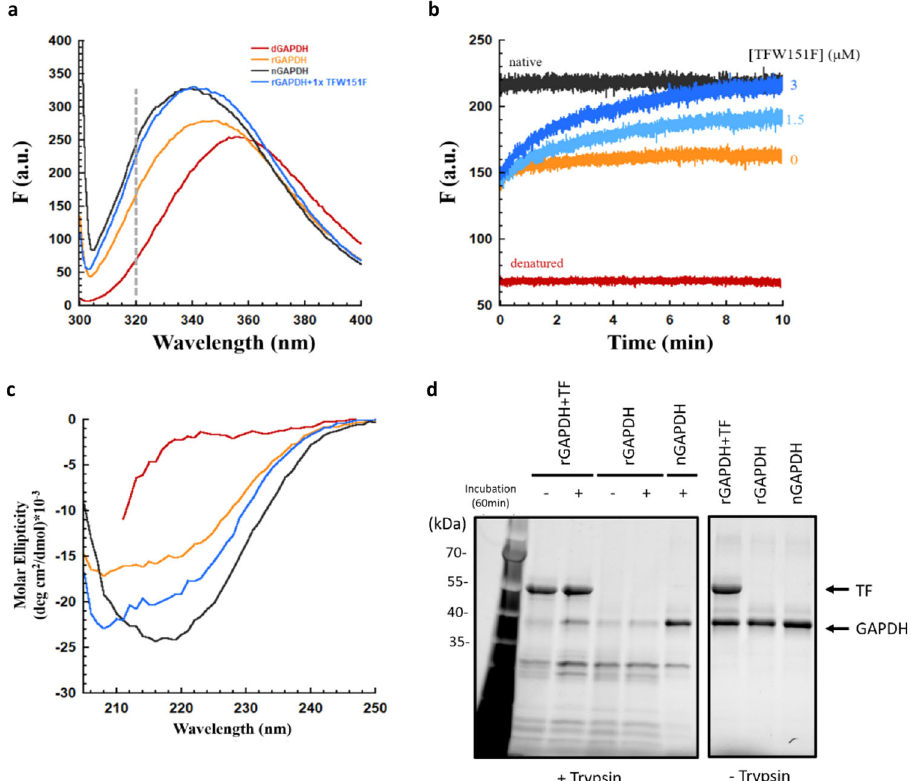
Fig. 3 GAPDH slowly refolds to a near-native state in the presence of trigger factor. a Tryptophan fl uorescence spectrum of 3 μ M refolding GAPDH (rGAPDH) with an equimolar amount of trigger factor W151F (rGAPDH + 1x TFW151F; blue line) is similar to the spectrum of native GAPDH (nGAPDH; black line), but different from the one of GdnHCl-denatured GAPDH (dGAPDH; red line) and refolding GAPDH (rGAPDH; orange line). All the spectra were measured in buffer A containing 0.26 M GdnHCl at 4 °C, except the spectrum of GdnHCl-denatured GAPDH which was measured in buffer A containing 3 M GdnHCl. The emission wavelength of 320 nm, which was marked as a grey dash line, was used to monitor the kinetics in Fig. 3b. a.u.: arbitrary units. b Changes in tryptophan fl uorescence of 3 μ M refolding GAPDH in the presence of various concentrations of trigger factor W151F (0, 1.5, 3 μ M) at 4 °C. Tryptophan residues were excited at 296 nm and fl uorescence emission was monitored at 320 nm. Upon dilution into buffer A, GAPDH slowly refolds to a near-native state, which exhibited a similar fl uorescence intensity as native GAPDH, within 10 min. a.u.: arbitrary units. c Circular dichroism spectra of 8.4 μ M GAPDH in a denatured state (red line), native state (black line), refolding state (orange line) and the trigger factor-bound state (blue line). All the samples were incubated on ice for 1.5 h prior to recording the spectrum. Upon dilution into buffer A, a signi fi cant increase in the signal of circular dichroism at 220 nm was observed. Addition of the trigger factor further increased the signal at 220 nm, suggesting that GAPDH increases the fraction of secondary structure in the presence of the trigger factor. d The conformational change of 5 μ M GAPDH in the presence of trigger factor as probed by limited proteolysis with trypsin. All the samples were either directly digested with 12.5 μ g/ml trypsin for 1 min at room temperature or incubated on ice for 1 h before trypsin digestion. Samples were then analysed by 4 – 15% Mini-PROTEAN TGX stain-free gels. The gel shows that refolding GAPDH in the presence of trigger factor (rGAPDH + TF) is more protease-resistant than GAPDH in the absence of trigger factor (rGAPDH). These experiments were independently repeated three times with similar